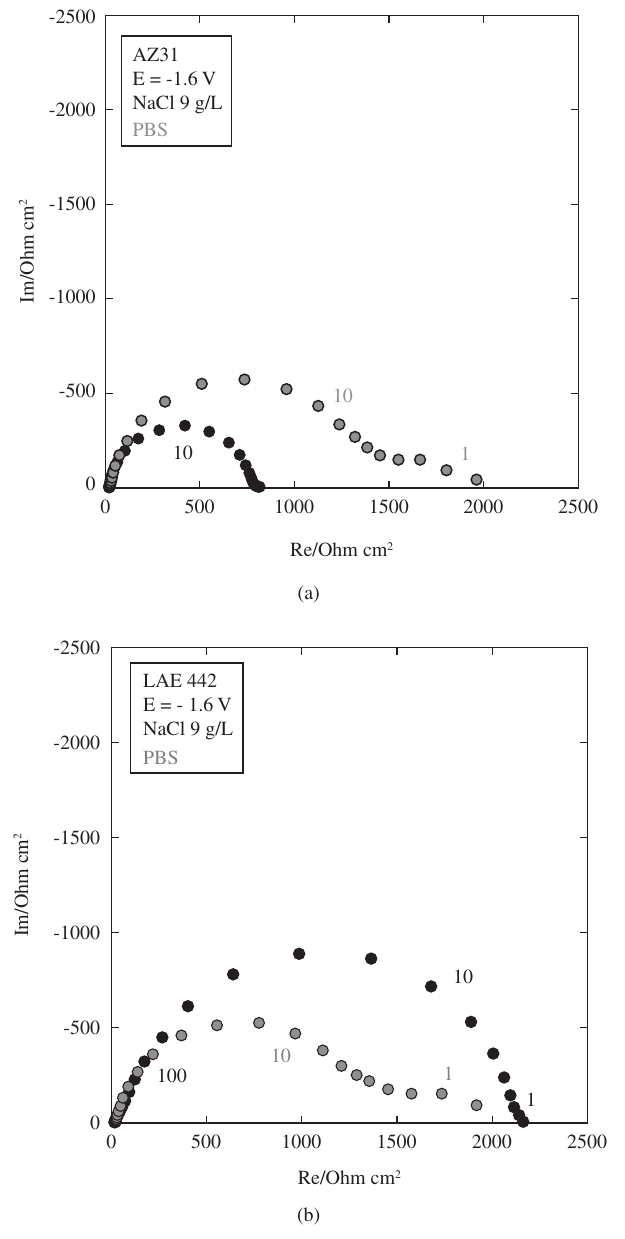
Figure 9. Comparison of impedance results of AZ31 and LAE442 alloys in 9 g/L NaCl solutions and PBS at E = -1.6